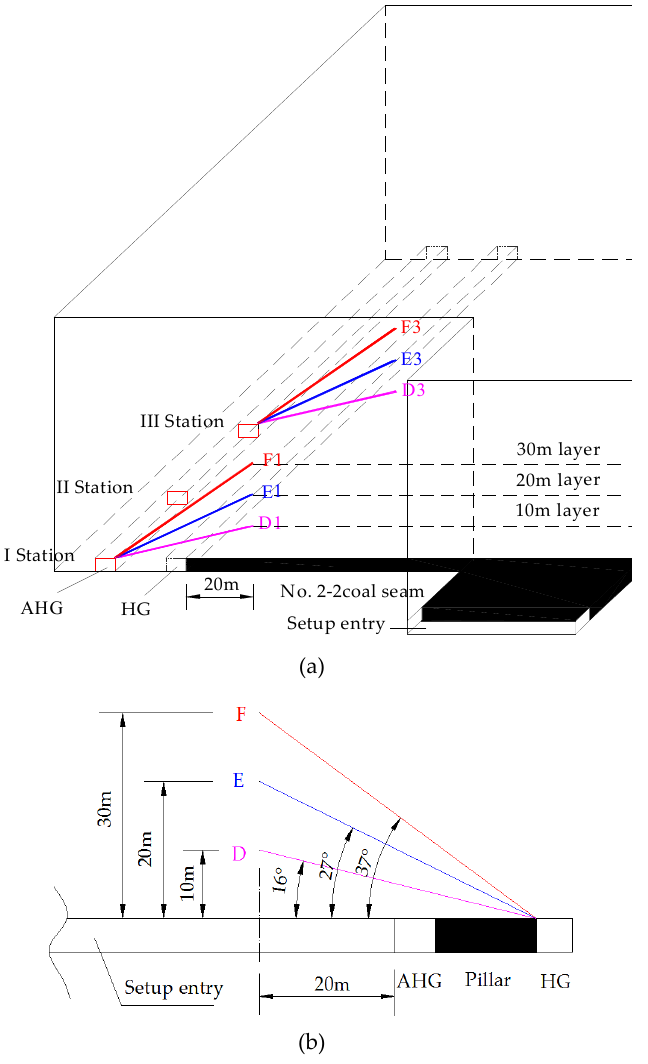
Figure 5. Schematic diagram of drilling: ( a ) spatial distribution map; ( b ) Sectional view along the working face.